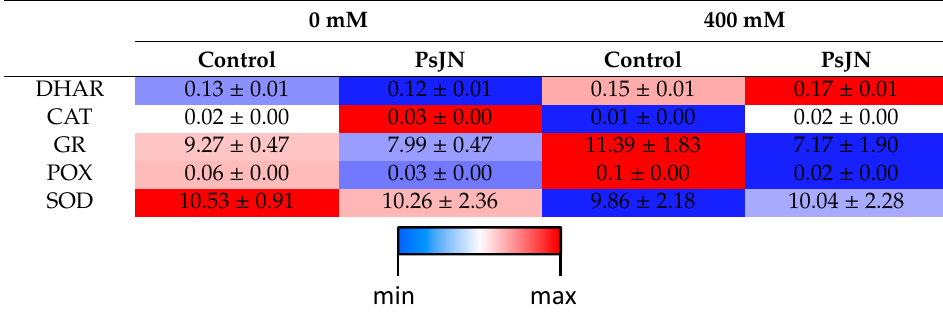
Table 2. Activity profile of five antioxidant enzymatic signature in quinoa leaf inoculated with Burkholderia phytofirmans PsJN and un-inoculated control grown under 0 mM and 400 mM salinity stressed greenhouse conditions represented as a heatmap based on a gradient red-white-blue color scale.